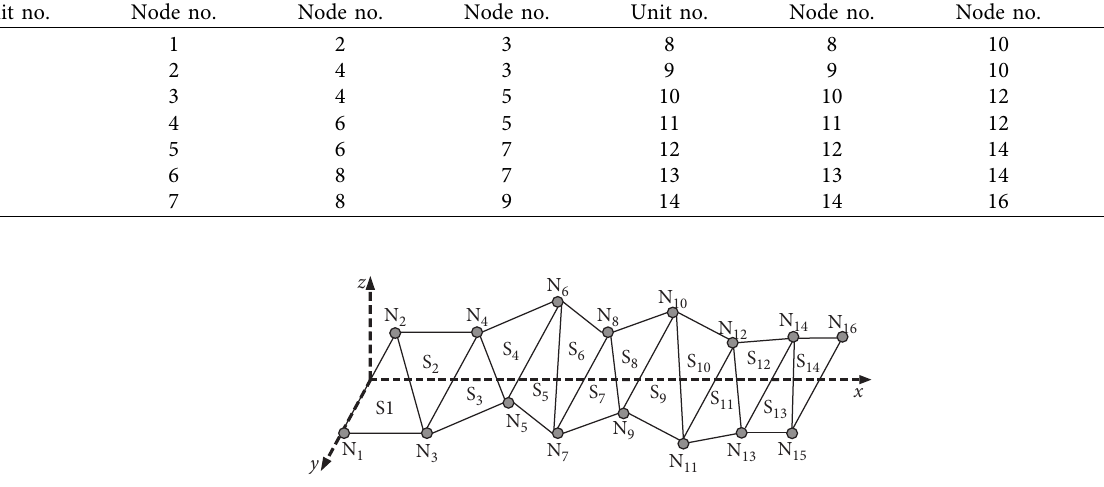
Figure 7: Schematic diagram of simulated pavement structure.